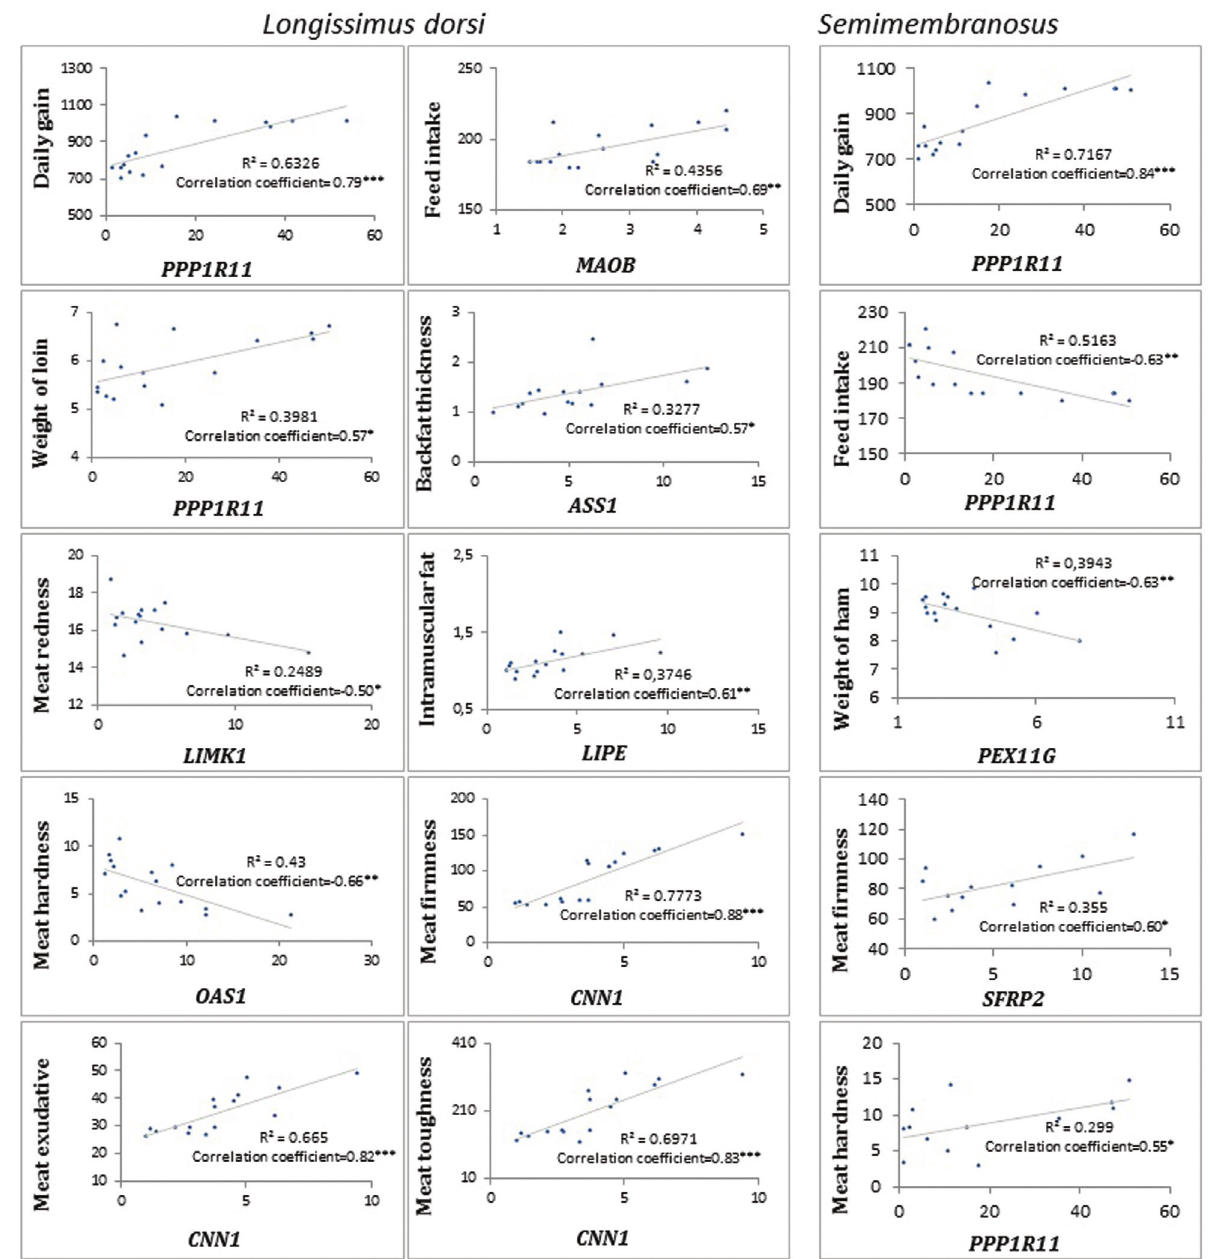
Figure2 -Regressionofgeneswithdifferentialexpressionin longissimusdorsi and semimembranosus musclesagainstimportantpigtraits.Geneexpres- sionispresentedasnormalizedFPKM.Unit:dailygain(g),feedintake(kg),backfatthickness(cm),weightofloin(kg),weightofham(kg),meatredness (A*), intramuscular fat (%), meat firmness (N/mm/s), meat hardness (N/mm/s), meat exudation (cm2). * P (cid:4) 0.05, ** P (cid:4) 0.01, *** P (cid:4)